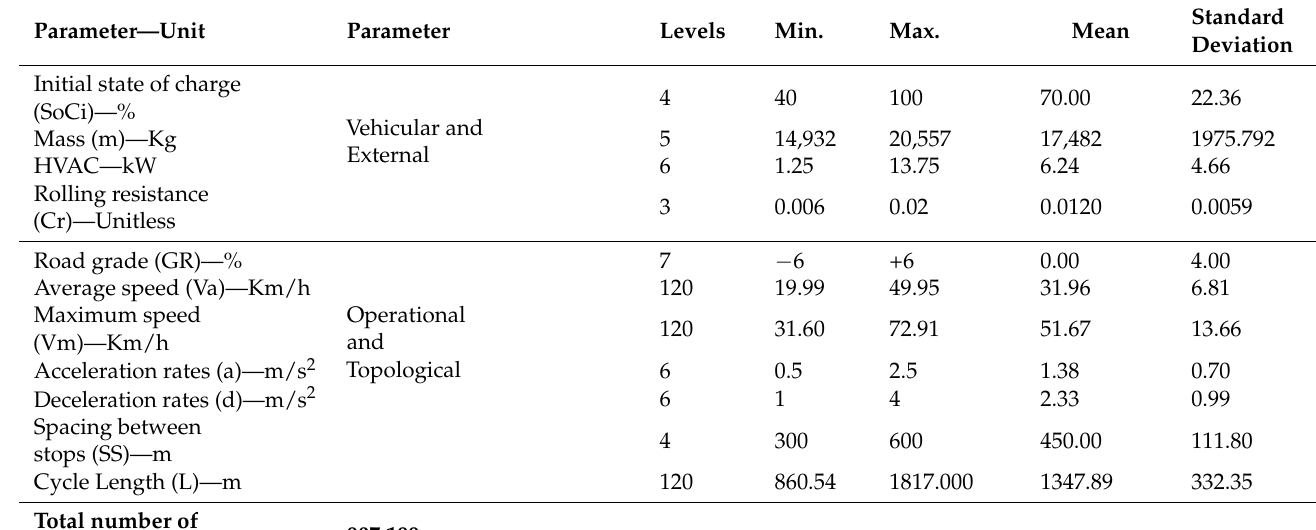
Table 4. List of input parameters used in full-factorial experiment